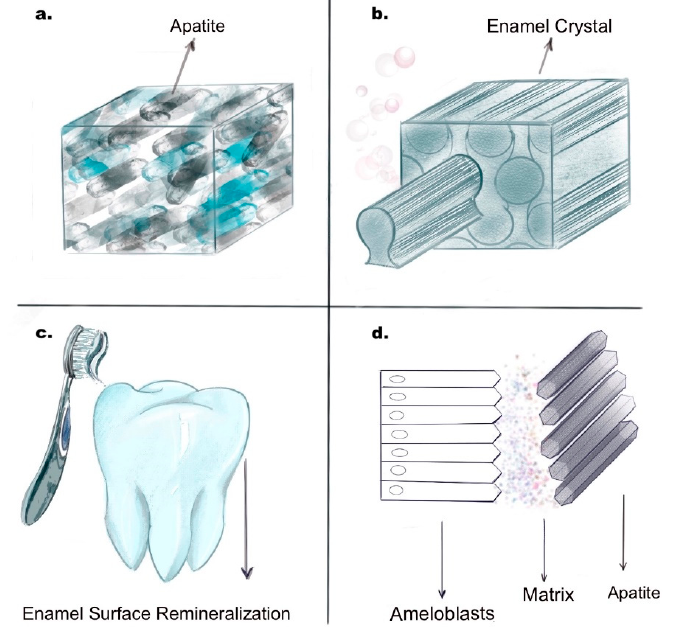
Figure 1. Mechanisms of enamel tissue engineering and regeneration: ( a ) physiochemical synthesis of apatite crystals, ( b ) protein-matrix-guided enamel crystal development, ( c ) enamel surface mineralisation using fluoride toothpastes, and ( d ) ameloblast (cell-based) tissue engineering of synthetic enamel apatite. Image adapted from [3] Pandya, M.; Diekwisch, T.G.H. Enamel biomimetics-fiction or future of dentistry. Int. J. Oral Sci. 2019 , 11 , 8. Copyright 2019 Springer Nature.